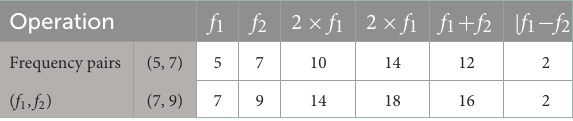
TABLE 1 Integer linear combinations up to order 2 in frequency set {(5, 7), (7,